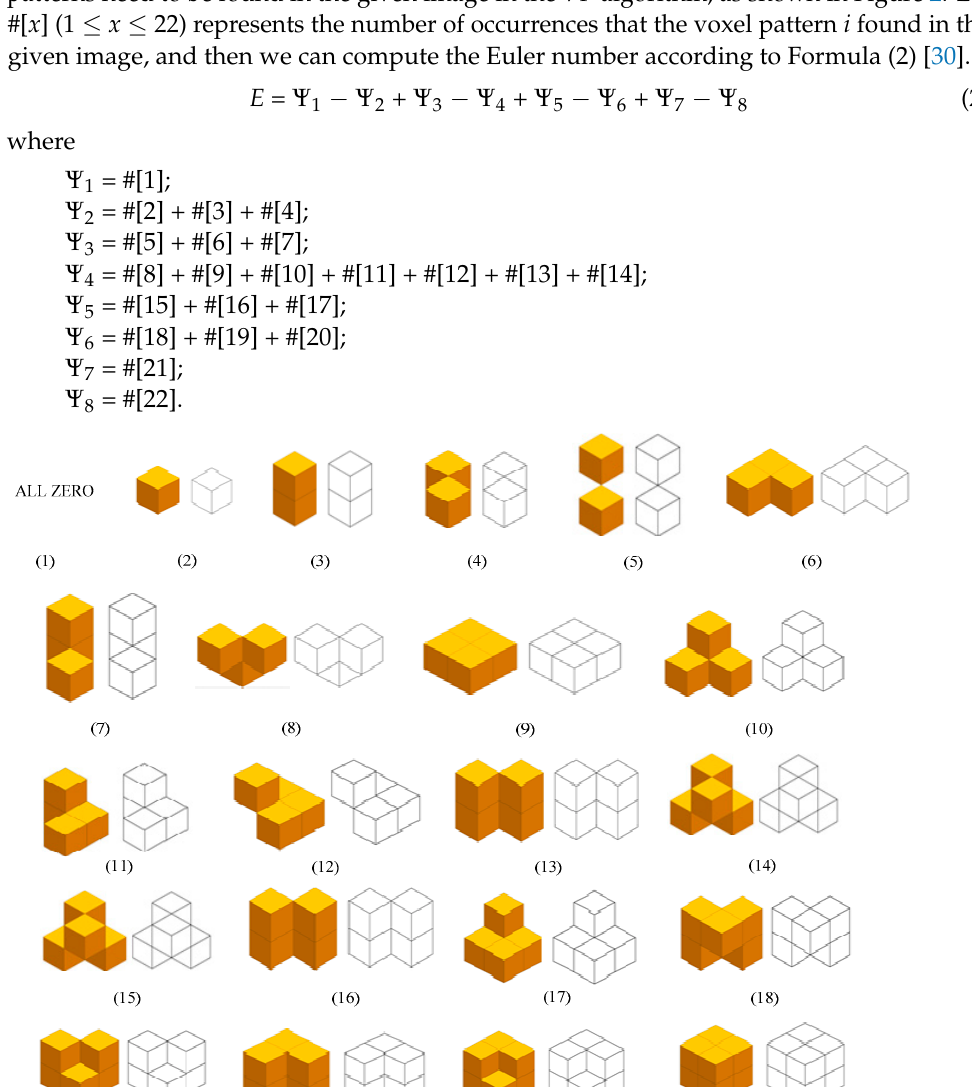
Figure 1. Illustration for explaining di ff erent adjacency among voxels.